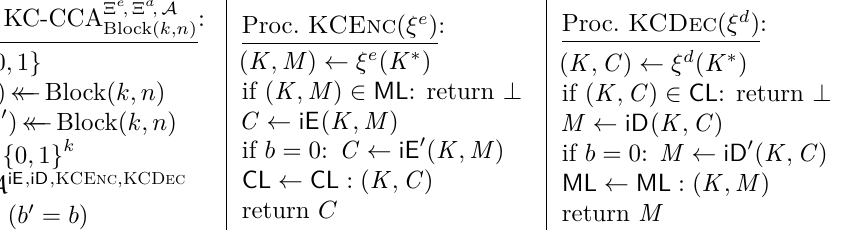
Figure 4: Game defining (Ξ e , Ξ d )-KC-CCA security of the ideal cipher with key length